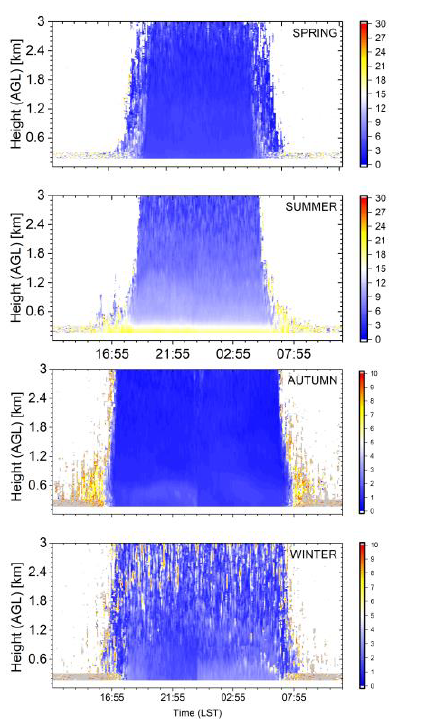
Figure 3 WVMR vertical distribution at difference